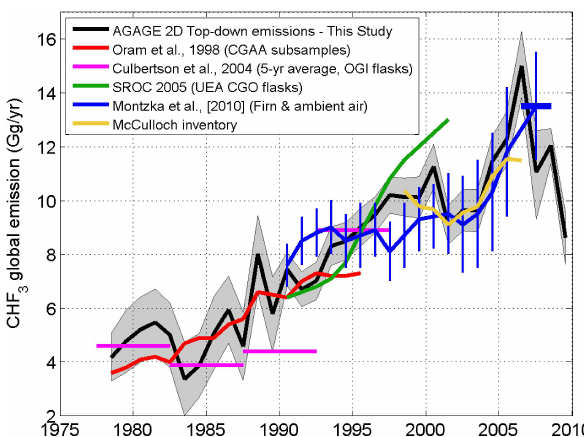
Fig. 6. Comparison of AGAGE HFC-23 (CHF 3 ) global emissions with other published results. The AGAGE 2-D 12-box model in- versions of AGAGE in situ and Cape Grim air archive data captures the 2001 to 2006 rapid rise in HFC-23 emissions that was first re- ported in a Montzka et al. (2010) study that was based on firn air and ambient air measurements. The AGAGE history resolves the rapid decrease in emissions to 2009. The estimates of Oram et al. (1998) are derived from UEA GC/MSD measurements of subsamples of the CGAA, thus bear strong resemblance to the AGAGE estimate. However, the extension of the UEA emissions beyond ∼ 1998 as given in the IPCC (2005) was based on flask samples that were con- taminated during filling (see text for details) and yielding steeper growth thereafter. The McCulloch (2004) estimates based on in- ventories show good agreement with AGAGE emissions for most of their common record, but decline as unaccounted production in developing countries begins to dominate global production. The Culbertson et al. (2004) 5-year average HFC-23 emission estimates agree well with other estimates for most years, but the 1990 ± 2.5 year average emission appears